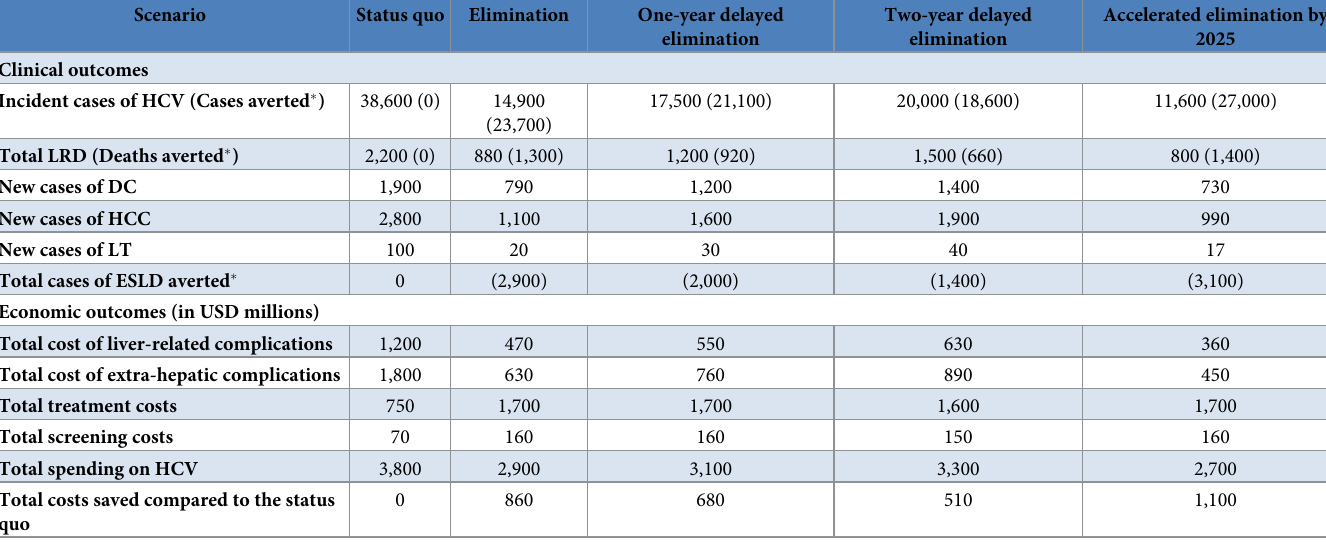
Table 3. Cumulative HCV-related clinical and economic outcomes by scenario,